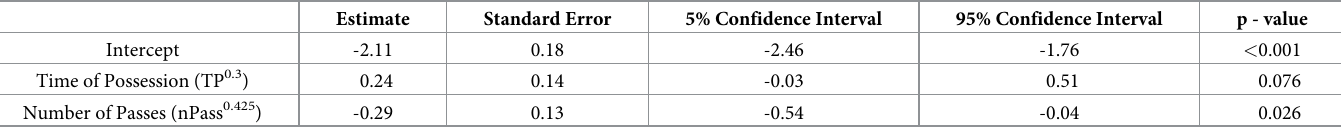
Table 3. Estimated log odds, standard errors, confidence intervals and p-values for a possession resulting in a shot.